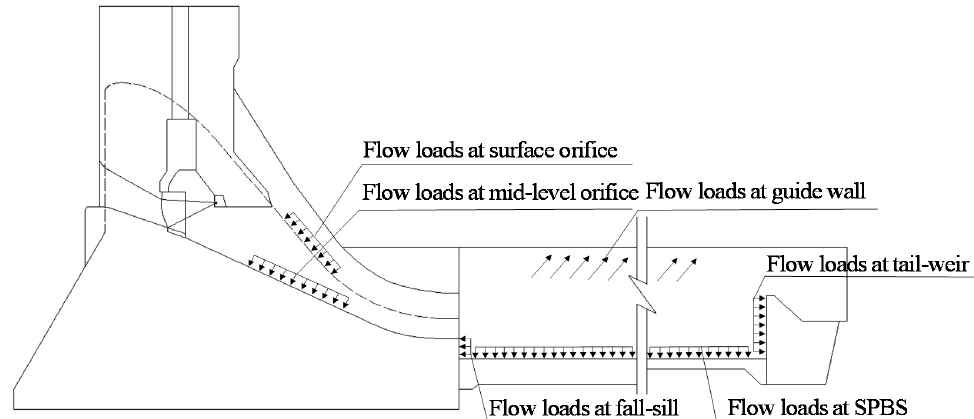
Figure 6. Location of different flow fluctuating loads.